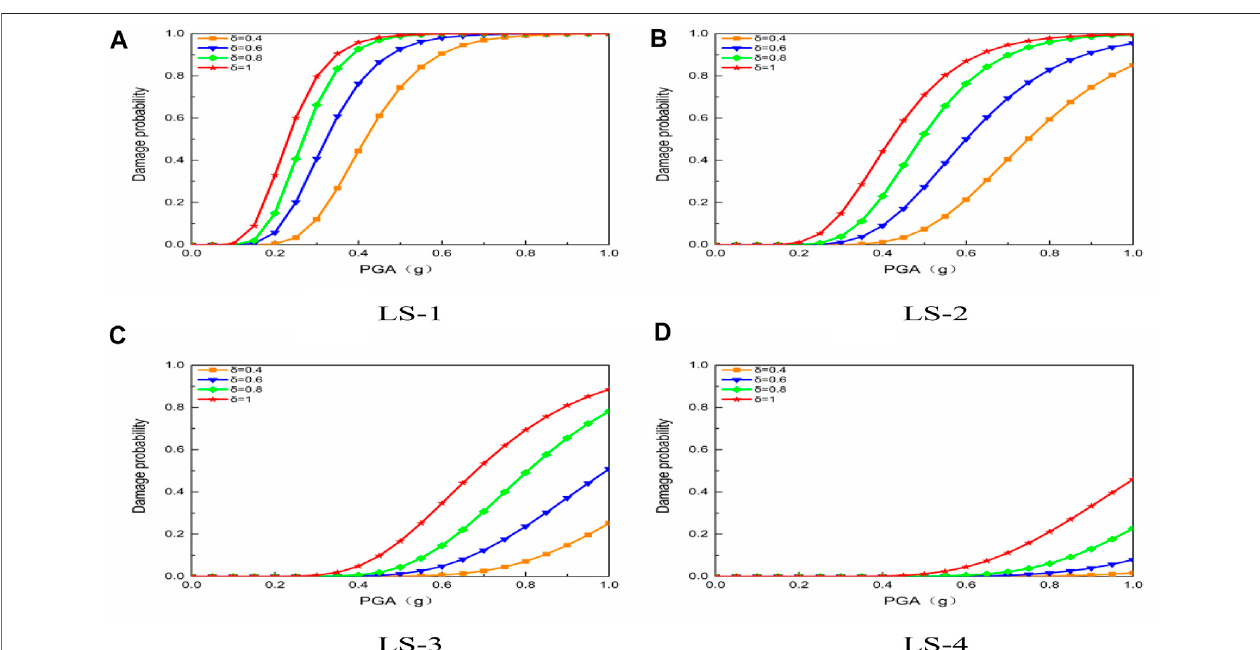
FIGURE 14 | The fragility curves of the mainshock-damaged CM model under aftershock. (A) LS-1 (B) LS-2 (C) LS-3 (D) LS-4.